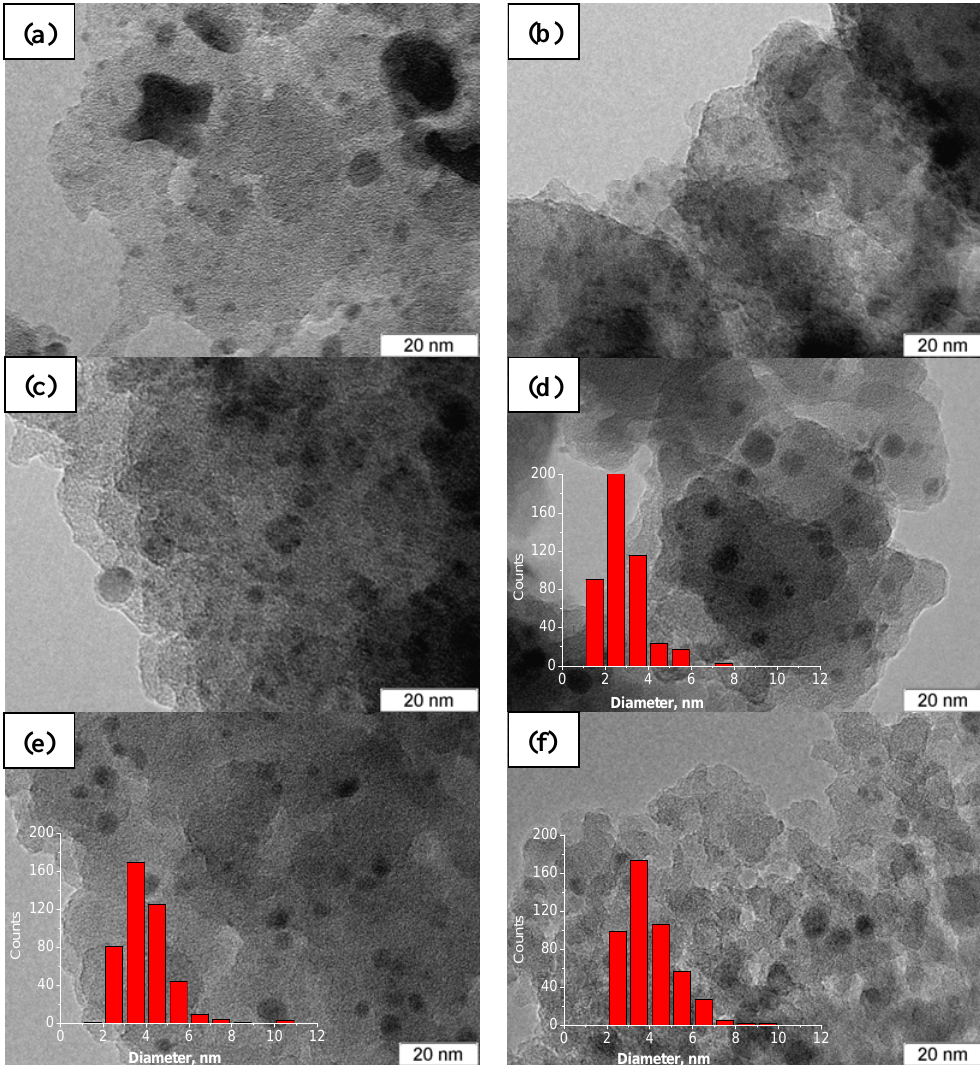
Figure 2. TEM images of Ni x P y /SiO 2 catalysts with different initial molar Ni/P ratio: ( a ) h -Ni2P1; ( b ) h -Ni1P1; ( c ) h -Ni1P2; ( d ) l -Ni2P1; ( e ) l -Ni1P1; ( f ) l